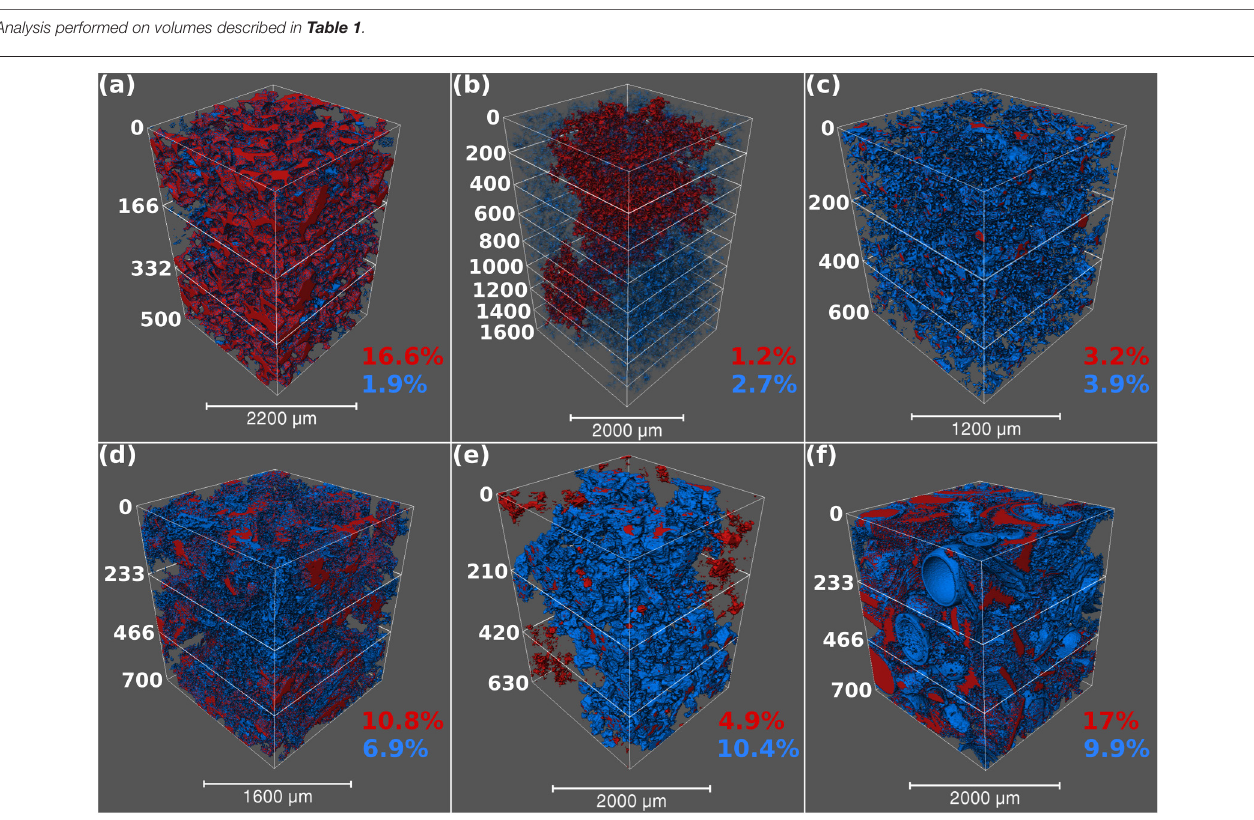
FIGURE 2 | Volume rendering visualization of the six different samples. From top, left to right: (a) Doddington sandstone showing connected macroporosity and total microporosity, (b) Knorringfjellet sandstone showing connected macroporosity and connected microporosity, (c) Wilcox sandstone showing total macroporosity and total microporosity, (d) Estaillades limestone showing connected macroporosity and connected microporosity, (e) Massangis Jaune limestone showing total macroporosity and connected microporosity, and (f) Savonnières limestone showing connected macroporosity and connected microporosity. For each volume the macroporosity is shown in red and microporosity in blue. Table 2 summarizes the volume fractions of porosity observed in all samples. Subdivisions are also shown here, from which the subvolume porosity analysis was